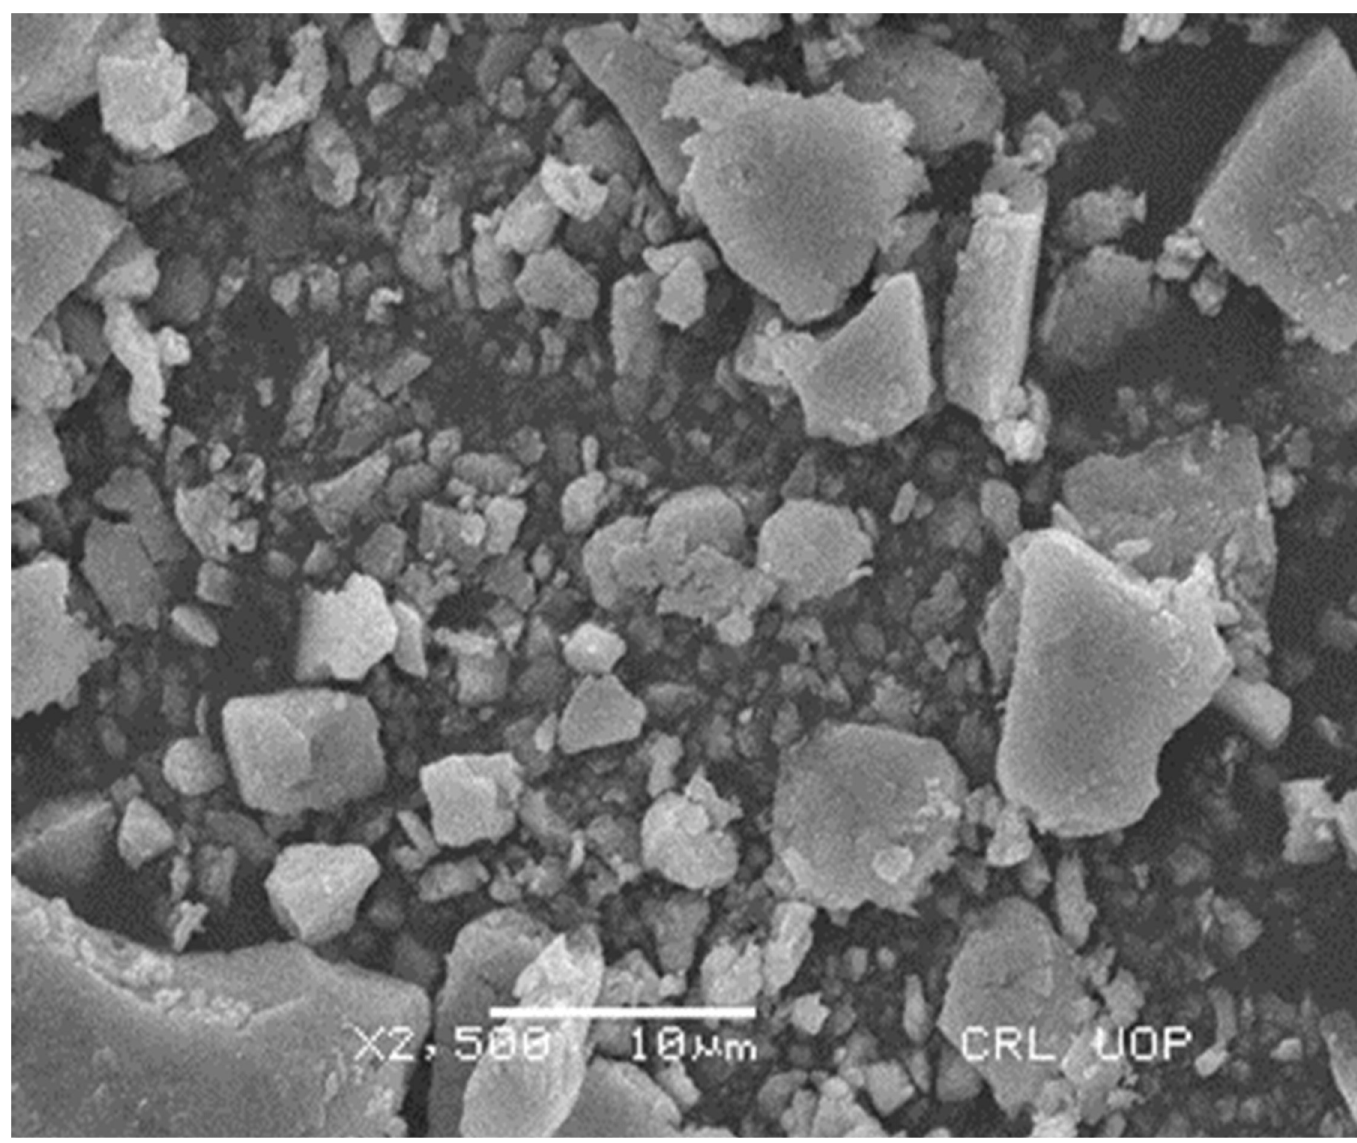
Fig 6. SEM image of green synthesized AgNPs with resolution power of X